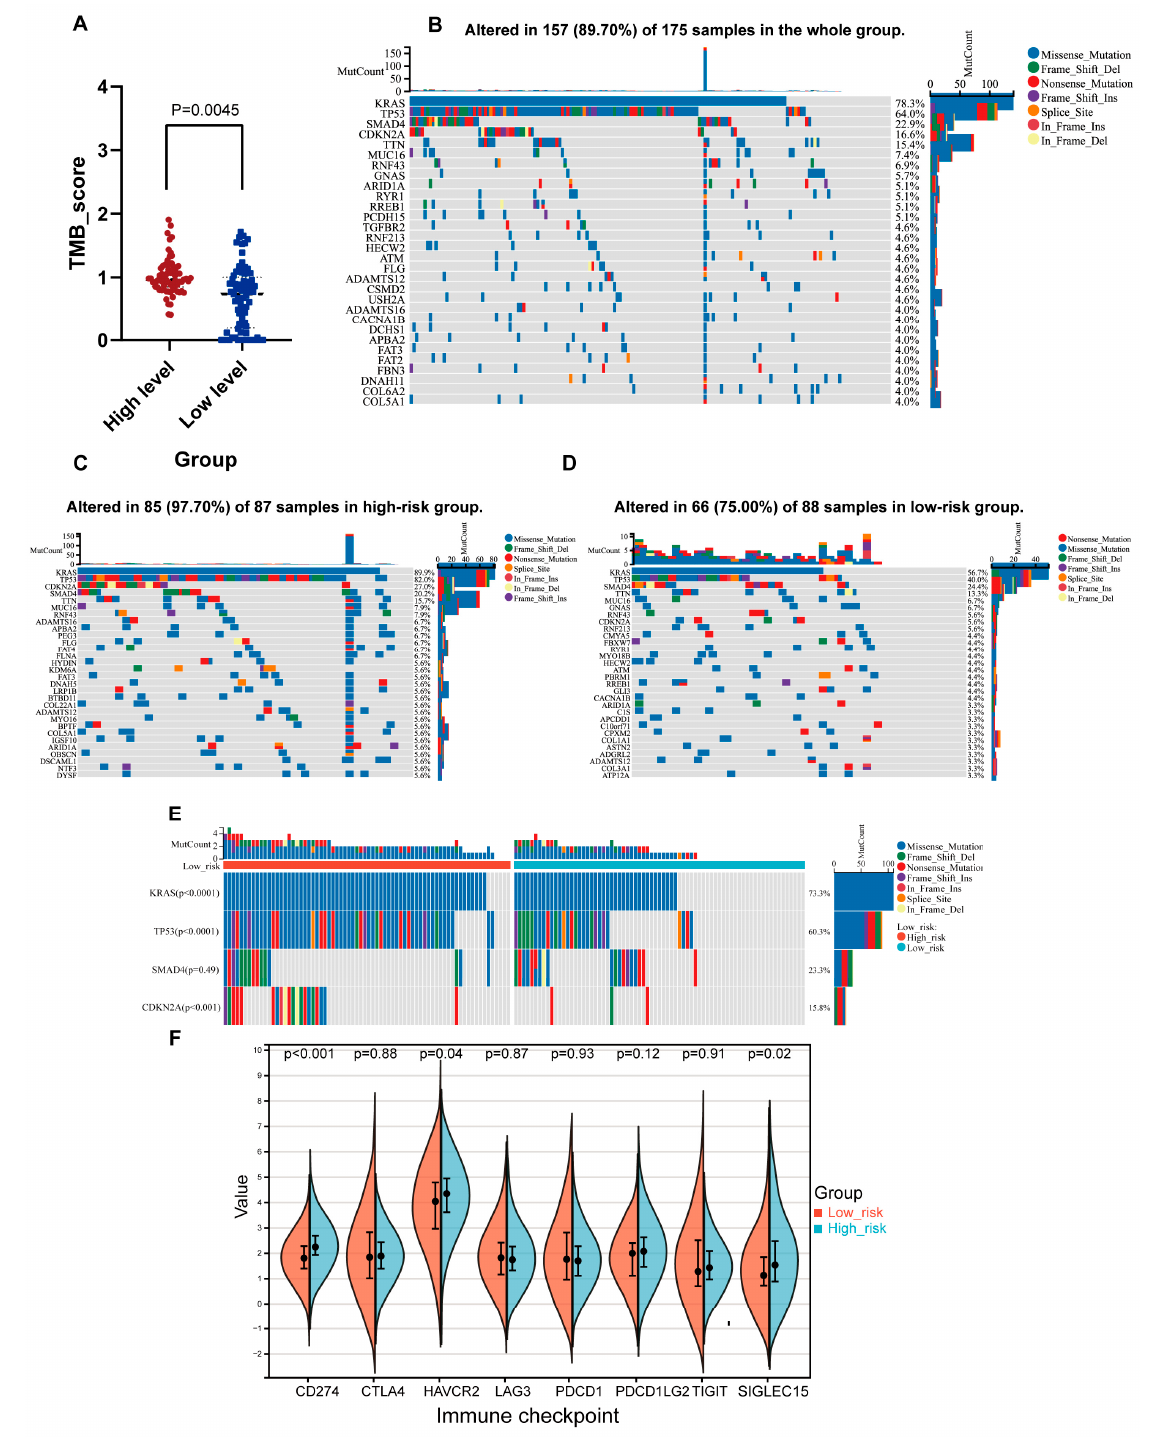
Figure 6. The analysis of genomic alterations between the high- and low-risk groups. ( A ) The boxplots show the tumor mutation burden between the high- and low-risk groups. ( B ) The overall genomic profiling of the top 30 most frequently altered genes in TCGA-PAAD cohort. ( C ) The genomic profiling of the top 30 most frequently altered genes in high-risk group cohort. ( D ) The genomic profiling of the top 30 most frequently altered genes in low-risk group cohort. ( E ) Comparison of the genomic profiling of four major genetic mutations of PC between the high-risk group and low-risk group. ( F ) Comparison of immune checkpoint expression levels between the high-risk group and low-risk